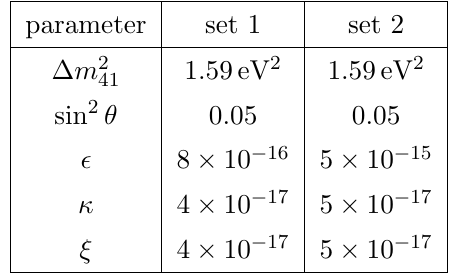
Table 2 . New oscillation parameters used in the analysis, with (cid:18) = ^ (cid:18) 14 = ^ (cid:18) 25 = ^ (cid:18) 36 . are the ones accounting for the oscillations measured experimentally, (cid:1) m 2 respectively. Consequently, at high energies they have to be equal to (cid:1) m 2 Choosing ^ (cid:18) = ^ (cid:18) = ^ (cid:18) is necessary in order not to spoil this behavior at high 14 25 36